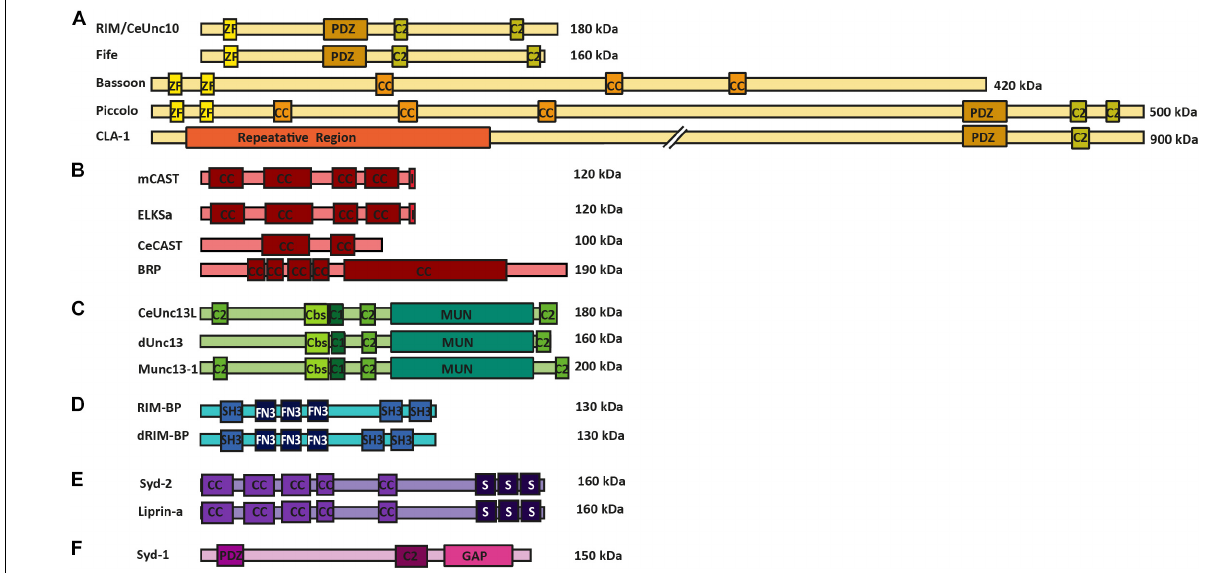
FIGURE 1 | AZ protein superfamilies in invertebrates and vertebrates. Molecular structure of AZ proteins grouped into superfamilies. (A) RIM superfamily is composed of RIM/Unc10, Bassoon, Piccolo, Fife, and Clarinet. These proteins possess an N-terminal zinc-finger domain (ZF), a PDZ domain and two C2 domains. Mammalian Bassoon and Piccolo proteins additionally possess three coiled-coil domains (CC). (B) ELKS/CAST/BRP superfamily of proteins contains multiple CC regions and an additional C-terminal IWA motif in the mammalian isoforms (I). (C) M(U)nc13 superfamily consists of Unc13L ( C. elegans ), Unc13 ( A,B isoforms in Drosophila ) and Munc13-1—4 in mammals. These proteins have two/three C2 domains, a calmodulin binding site (Cbs) (with the exception of Unc13B), a C1 domain, and a MUN domain. (D) dRIM-BP ( Drosophila ) and RIM-BP form a superfamily of AZ proteins that possess an interruption of three contiguous FN3 domains between their first and last SH3 domains (E) Syd-2 /Liprin α family contain five CC regions and three C-terminally located SAM domains. (F) Syd-1 family possess a PDZ domain, C2 domain and a unique Rho-GAP